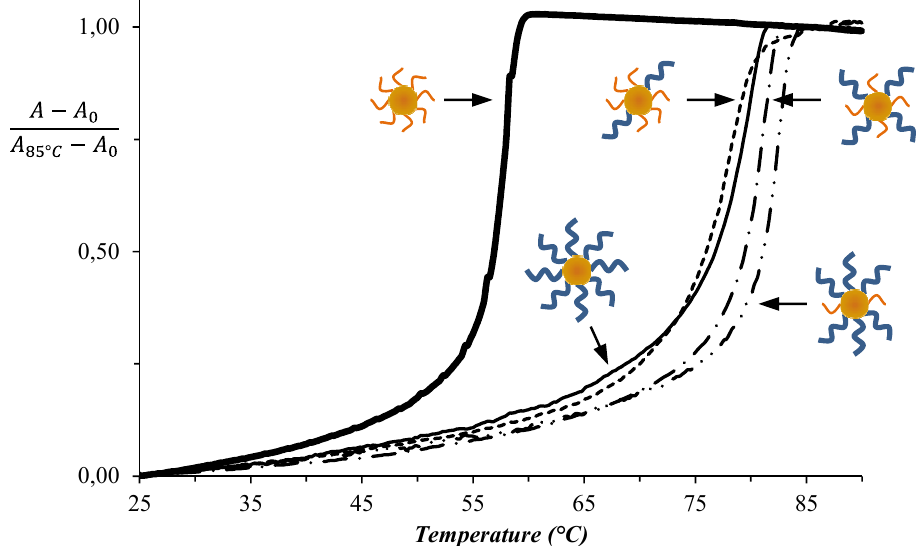
Figure 4. Normalized absorbance at 260 nm during assembly of AuNP functionalized and mixed AuNP functionalized with (i) T10-DNAA (plain); with T10-DNAT 11 11 (ii) T10-DNAA /T10-DNAA (25/75) (dotted); (iii) T10-DNAA /T10-DNAA (50/50) 11 5 11 5 /T10-DNAA (75/25) (dotted-double point) and (dotted-point); (iv) T10-DNAA 11 5 (v) T10-DNAA (bold) in function of 5